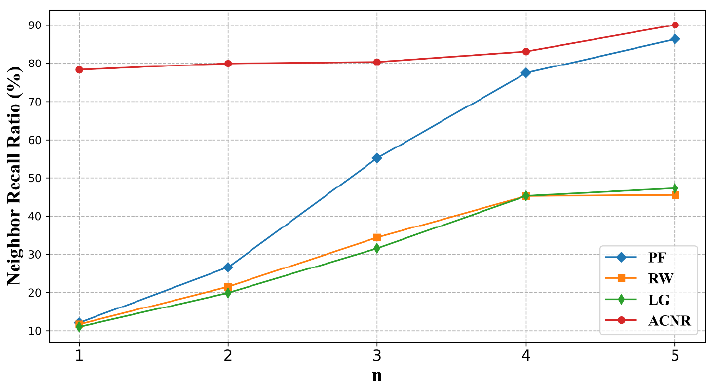
Figure 3. Neighbor recall ratio comparison for each algorithm with different discovery rounds at the middle level.